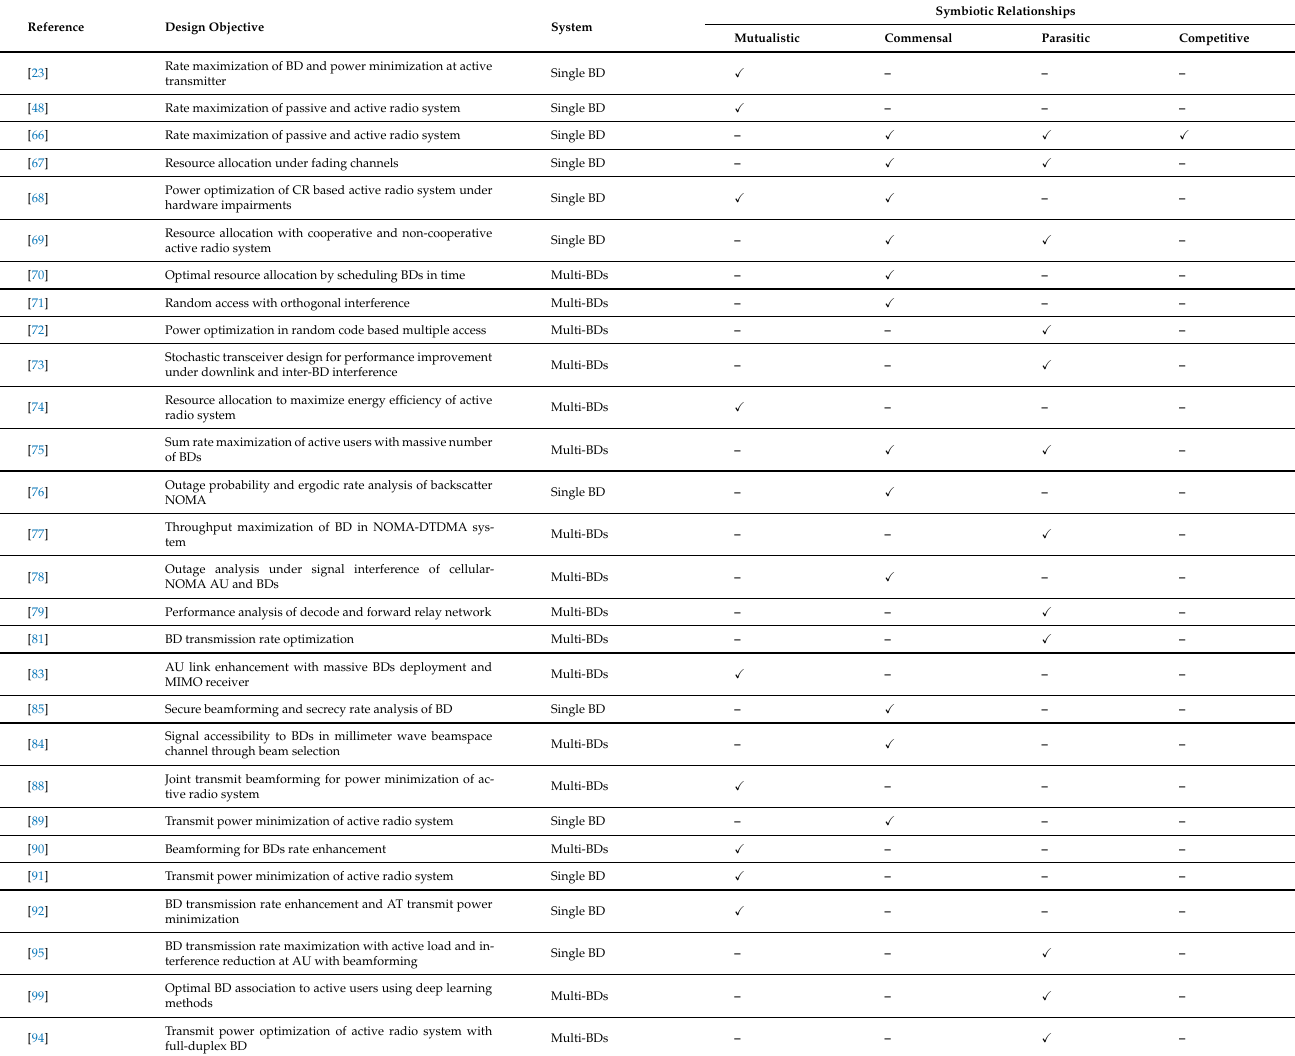
Table 1. Overview of SRad system